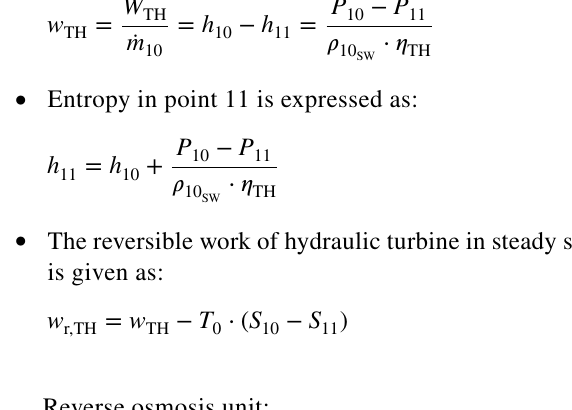
Fig. 9 Efficiency of Rankine cycle versus pressure of condensation of the reverse osmosis at different thermal combustions and constant flow rate of steam